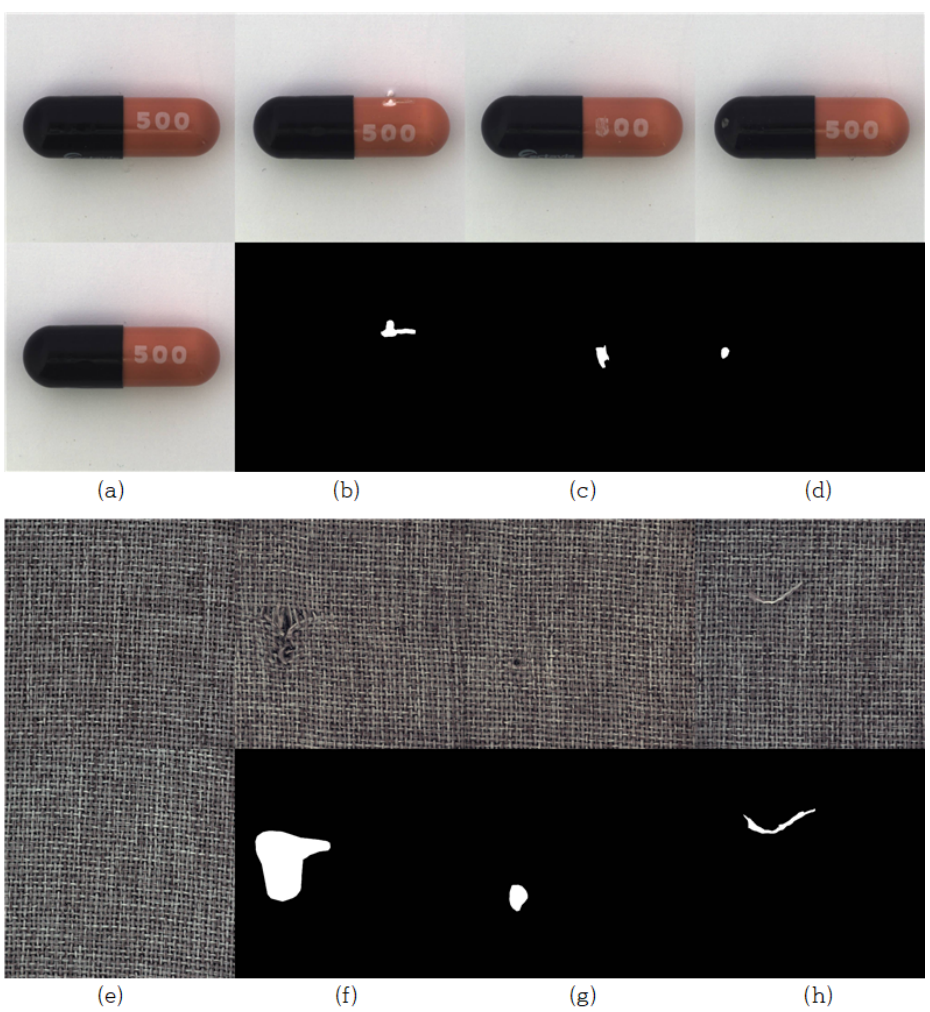
Figure 6. Normal and abnormal images for the capsule and carpet included in the MVTecAD dataset. For the capsule and carpet, ( a , e ) are normal images and ( b – d , f – h ) are defective images and abnormal mask images, respectively. The reason for the defect in the abnormal images of the capule is: ( b ) crack; ( c ) faulty imprint; ( d ) fork. The reason for the defect in the abnormal images of the carpet is: ( f ) cut; ( g ) hole; ( h )